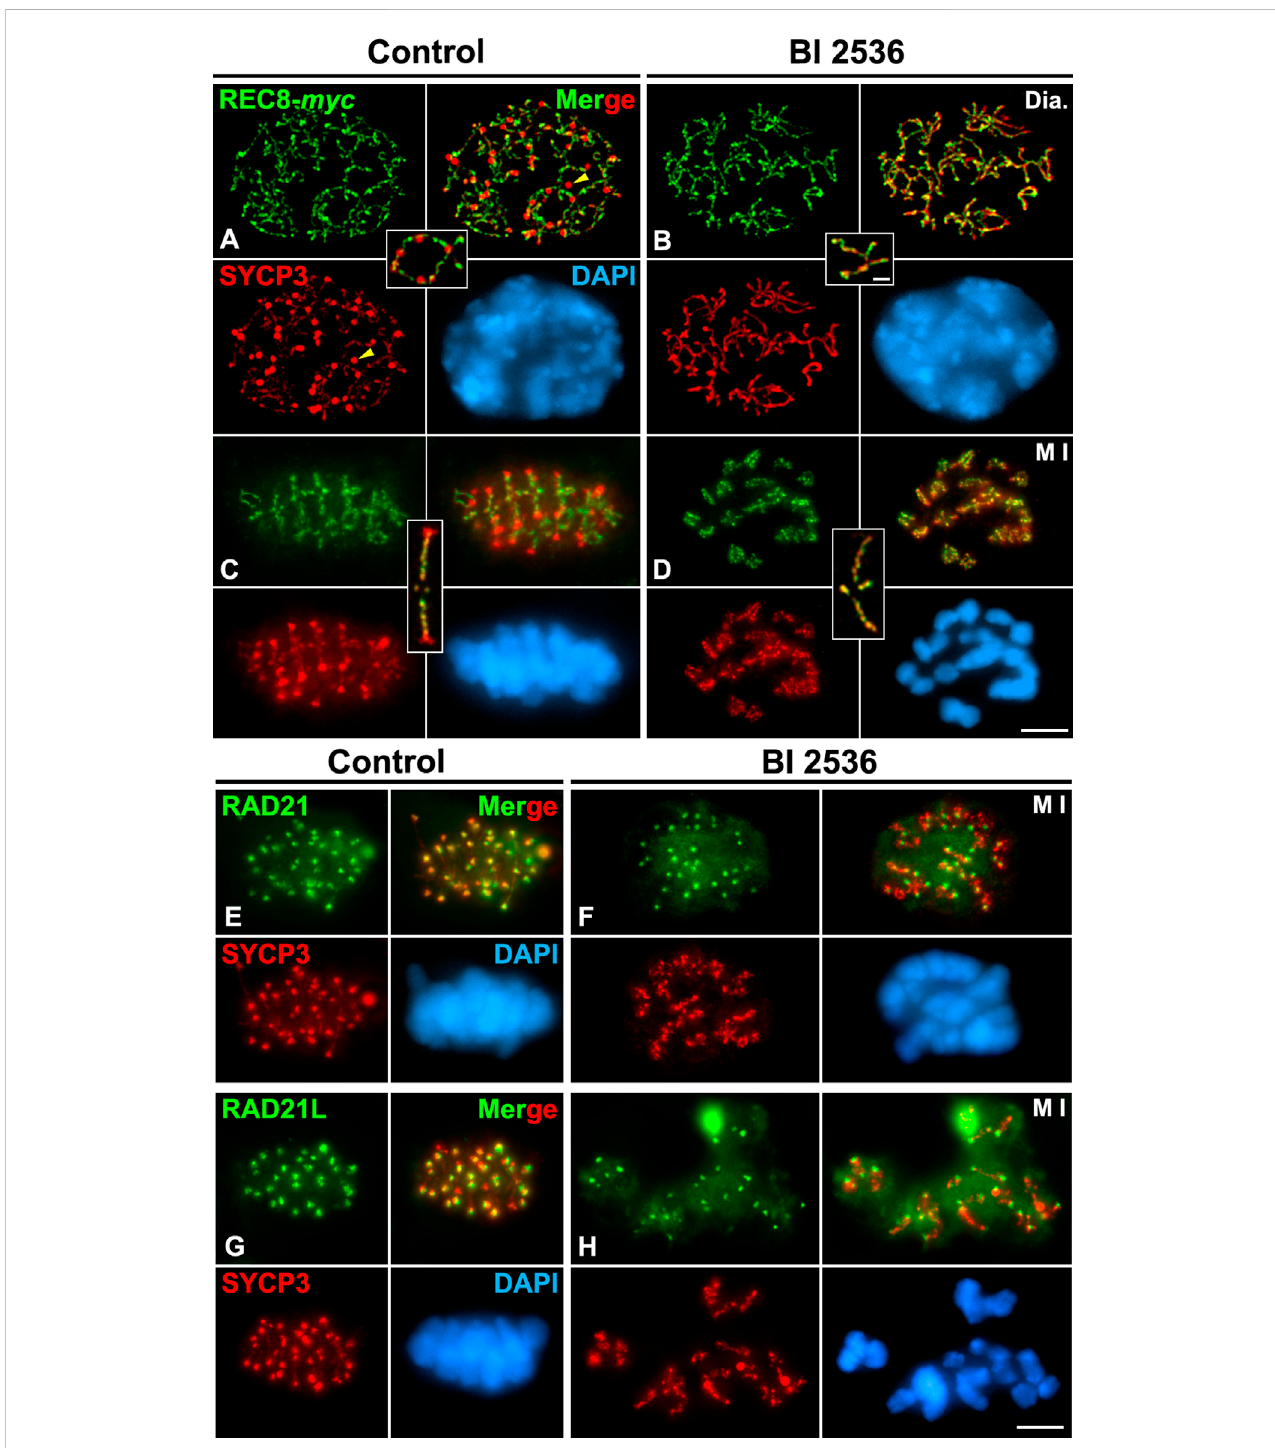
Inhibition of PLK1 does not alter the distribution of REC8, RAD21 and RAD21L-contanining cohesin complexes in diakinesis and metaphase I spermatocytes. DoubleimmunolabelingsofREC8- myc (greenin A – D ),RAD21(greenin E,F )orRAD21L(greenin G,H )andSYCP3(red),andcounterstainingofthechromatinwithDAPI (blue) onsquashed control (A,C,E,G) and BI 2536-treated (B,D,F,H) diakinesis (Dia.) (A,B) andmetaphase I (M I)spermatocytes (C – G) . Selected autosomal bivalents in diakinesis (A,B) andmetaphaseI (C,D) spermatocytesareshown.YellowarrowheadsindicateagglomeratesofSYCP3inthenucleoplasmofthecontroldiakinesis spermatocyte. Scale bars represent 5 μ m in (A – H) , and 1 μ m in selected diakinesis and metaphase I bivalents in (A – D) .